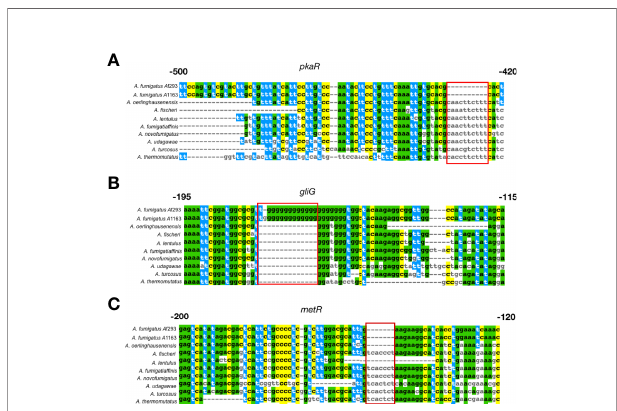
FIGURE 5 | Notable examples ofsequence differences between A fumigatus andits close relatives innon-codingregionslocated upstream ofthree known genetic determinants of A fumigatus virulence that exhibited signatures of a different evolutionary rate. (A) pkaR encodes a regulatory subunitinvolved in the regulation of the cyclic AMP – dependent proteinkinase pathway;deletion of pkaR in A fumigatus has been shownto attenuate virulence in a neutropenic mouse model (Zhao et al., 2006).The sequence alignment of the non-coding region of the pkaR gene exhibits a 10 bp region (red box)that isuniquely deleted in A fumigatus but present inall other close relatives. (B) gliG encodes for a glutathione S-transferase (GST)thatis part of the gliotoxin biosyntheticgene cluster and isrequired for gliotoxin production (Scharf et al., 2011).Gliotoxin contributes to the virulence of A fumigatus , inactivating host vital proteins via conjugation (Scharf et al., 2011).The sequence alignmentof the non-coding region upstream ofthe gliG gene exhibits a 15 bpG-rich region that has been insertedin A fumigatus and isabsent from allother species. (C) metR encodes for a TFinvolvedin sulfur assimilation and isa known A fumigatus virulence factor (Amich et al., 2013). The sequence alignment of the non-codingregion of the metR gene contains a 7 bpregion that isabsent only in A fumigatus, A oerlinghausenensis , and A lentulus . Colored nucleotides represent sites that are present in A fumigatus Af293 andshared between other species, highlighting differences between the reference strain andclose